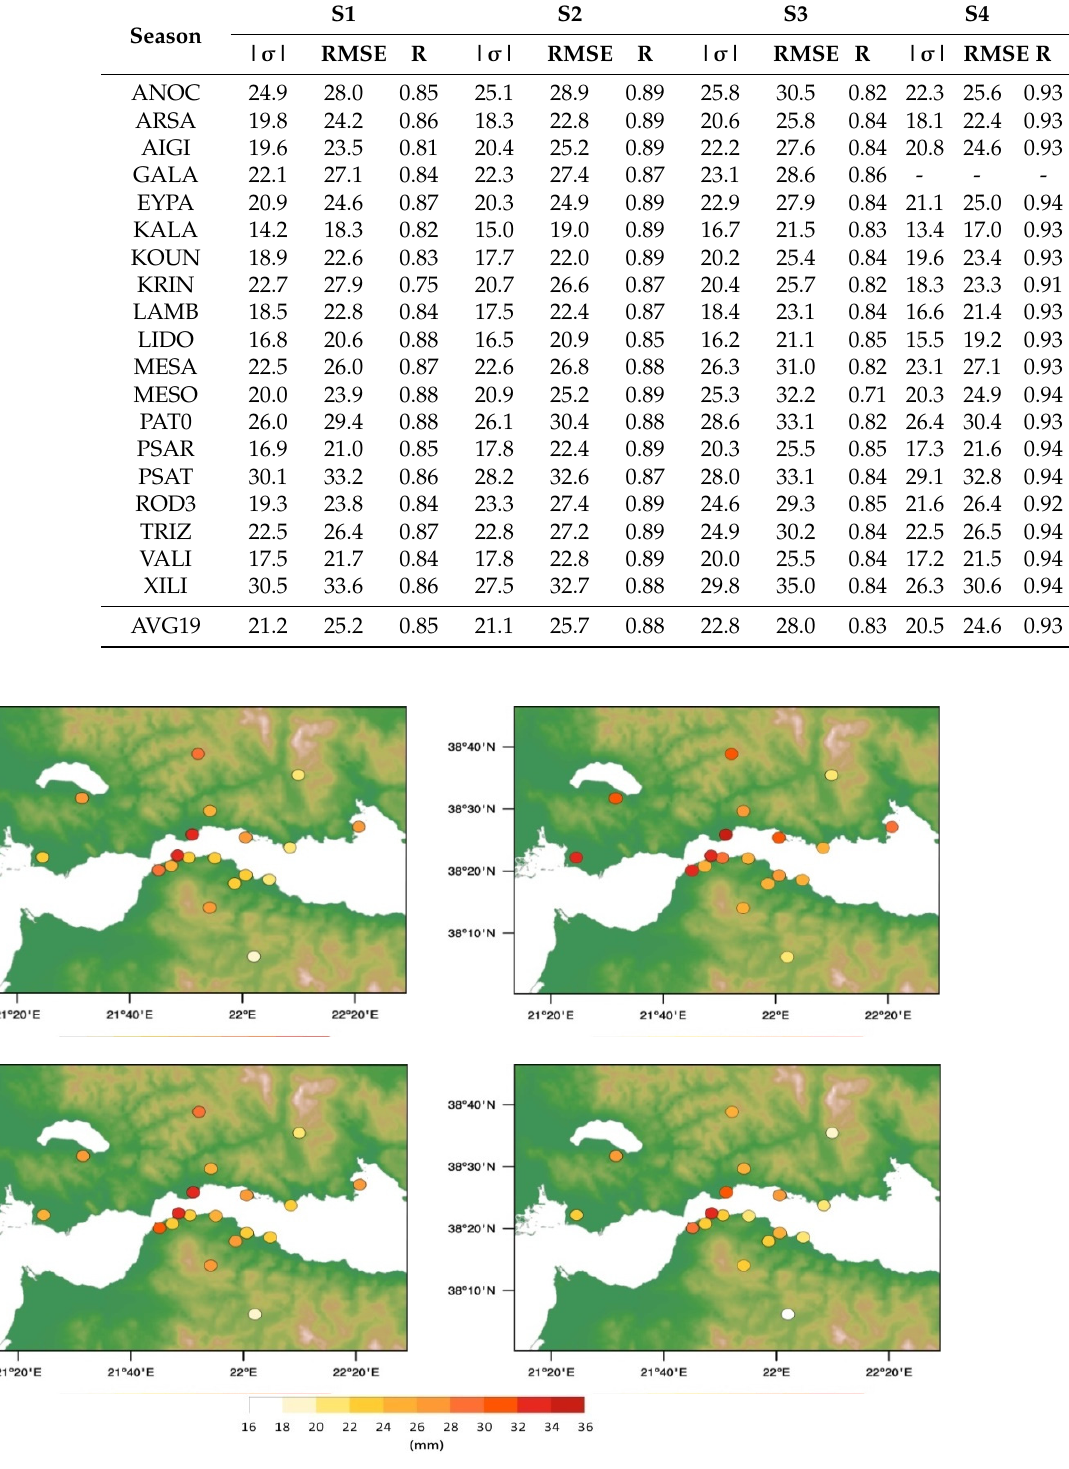
Figure 11. RMSE per station and season (S1 top left, S2 top right, S3 bottom left, S4 bottom right).